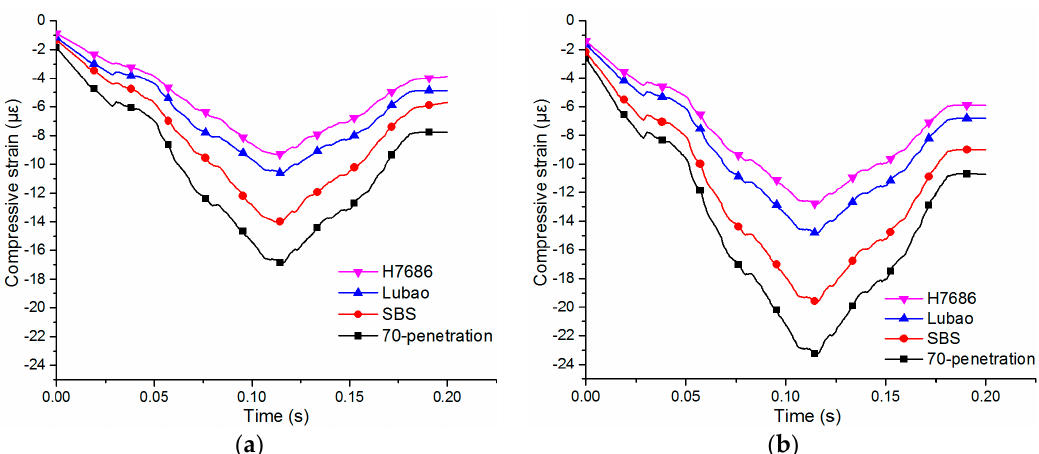
Figure 11. Compressive strains at top center of subgrades: ( a ) under standard load; ( b ) under heavy load.